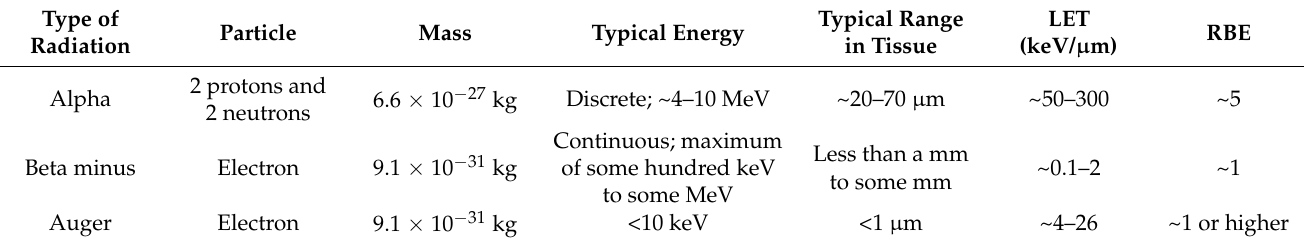
Table 1. Overview of types of